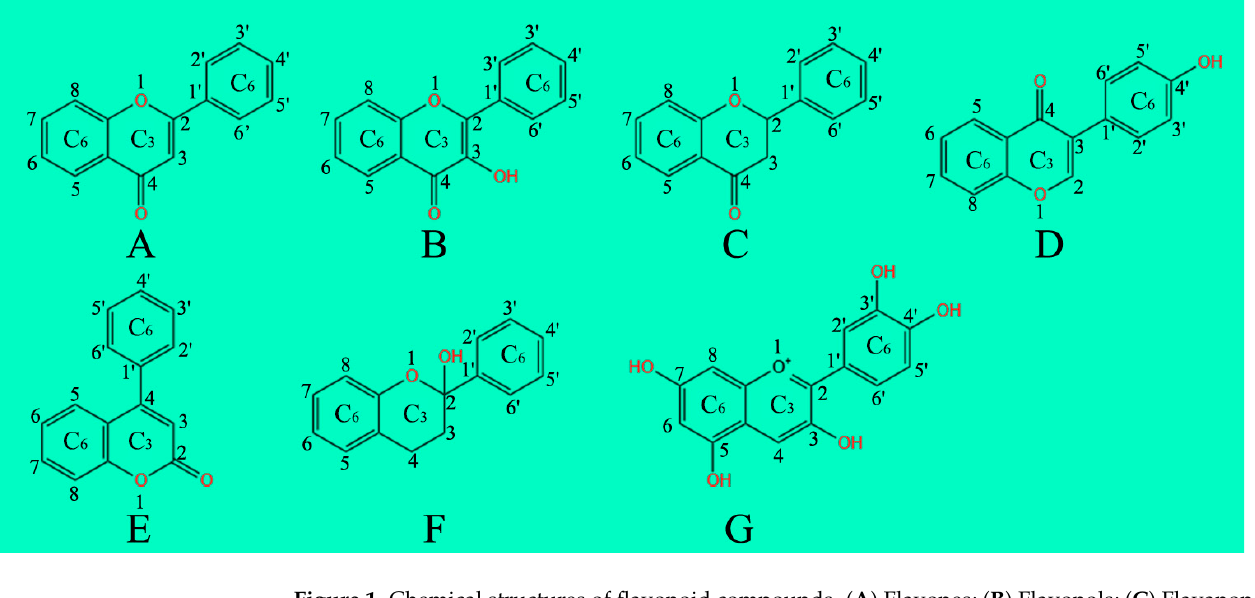
Figure 1. Chemical structures of flavonoid compounds. ( A ) Flavones; ( B ) Flavonols; ( C ) Flavanones; ( D ) Isoflavonoids; ( E ) Neoflavonoids; ( F ) Flavanols; ( G ) Anthocyanins.